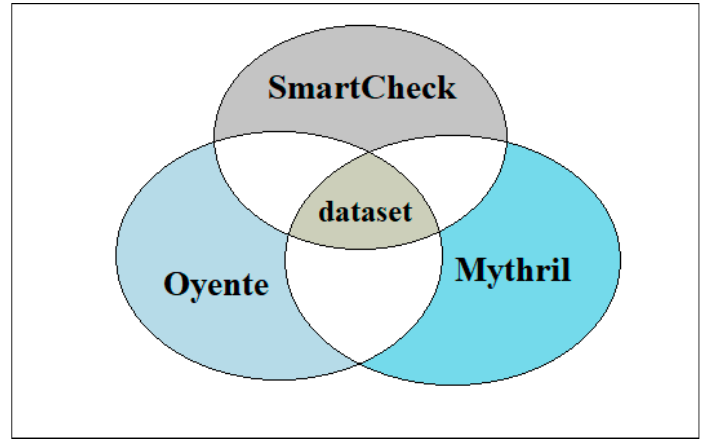
Figure 8. Dataset contains 2918 smart